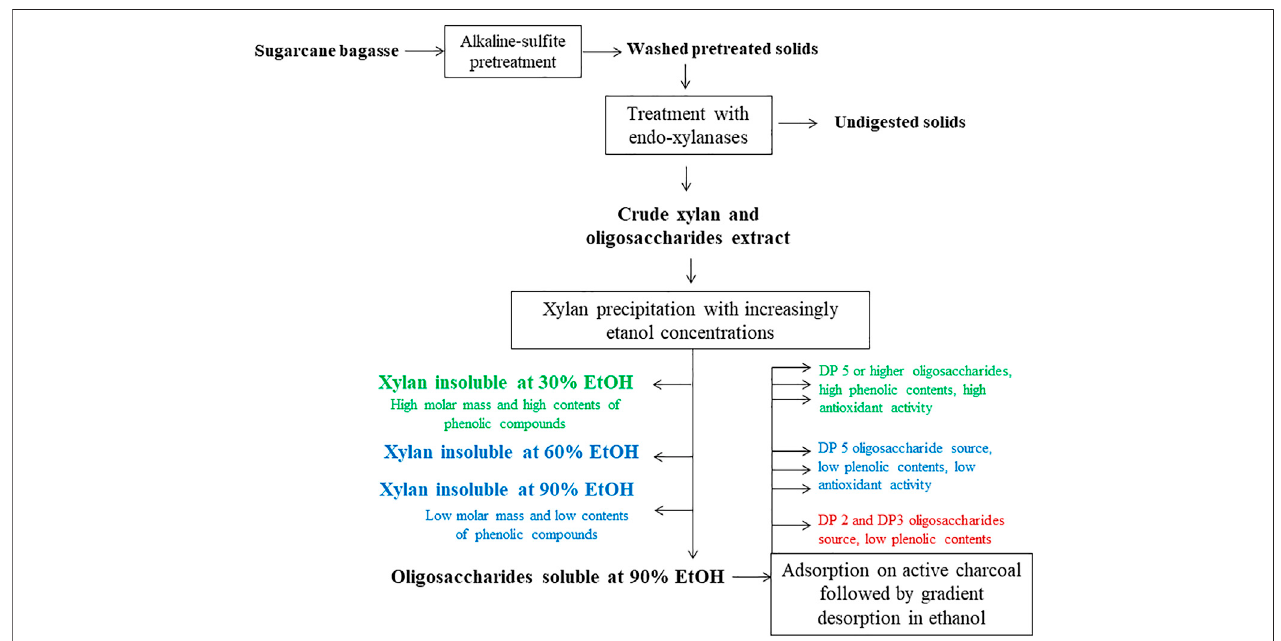
FIGURE 7 | Sugarcane bagasse biore fi nery scheme focused on developing new products from the GAX fraction retained after alkaline-sul fi te pretreatment.